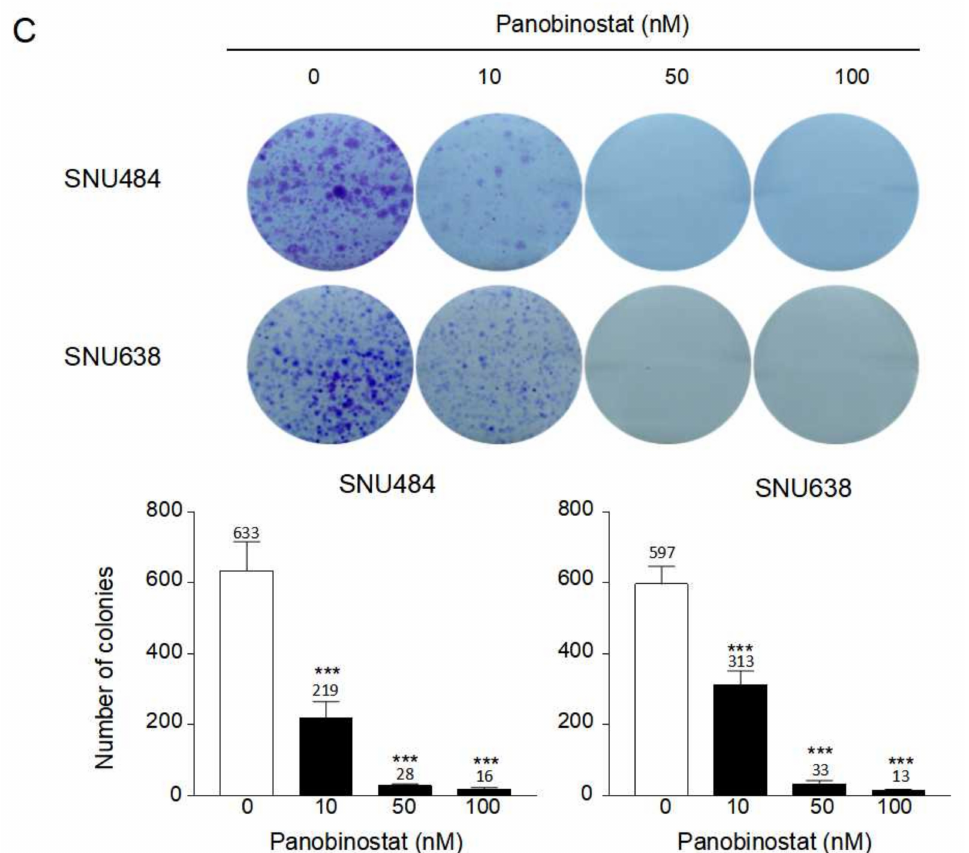
Figure 1. Panobinostat suppresses the proliferation of gastric cancer cells. ( A ) Human gastric cancer cell lines SNU484 and SNU638 were treated with panobinostat (0, 10, 50, and 100 nM) or DMSO for 48 h. ( A ) Histone acetylation was induced by panobinostat treatment in a dose-dependent manner, whereas no change in histone H3 and H4 in SNU484 and SNU638 GC cells was observed (0, 10, 50, and 100 nM). GAPDH was used as an internal control. The Western blot band intensity was quantitatively analyzed using ImageJ software (NIH, Bethesda, MD, USA). Data represent the mean ± SE of three independent experiments. * p < 0.05, ** p < 0.01, and *** p < 0.001 in comparison to the control. ( B ) Cell viability was measured by WST assays. Data are shown as the mean ± SD of more than three independent experiments with five dishes per experiment. *** p < 0.001 compared with the control. ( C ) A colony formation assay was performed using SNU484 and SNU638 cells treated with panobinostat (0, 10, 50, and 100 nM) to assess proliferation. Colonies were imaged. Data are shown as the mean ± SD of more than three independent experiments. *** p < 0.001 compared with the control. DMSO, dimethyl